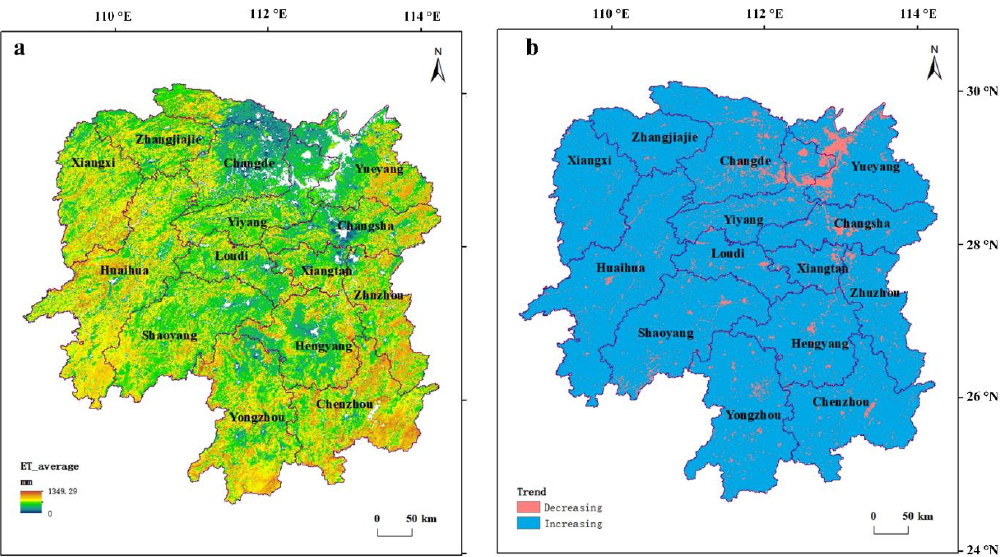
Figure 4. Spatial distribution of average annual evapotranspiration (ET) based on the data from 2010 to 2019 in Hunan Province ( a ), and its trend during this period ( b ).